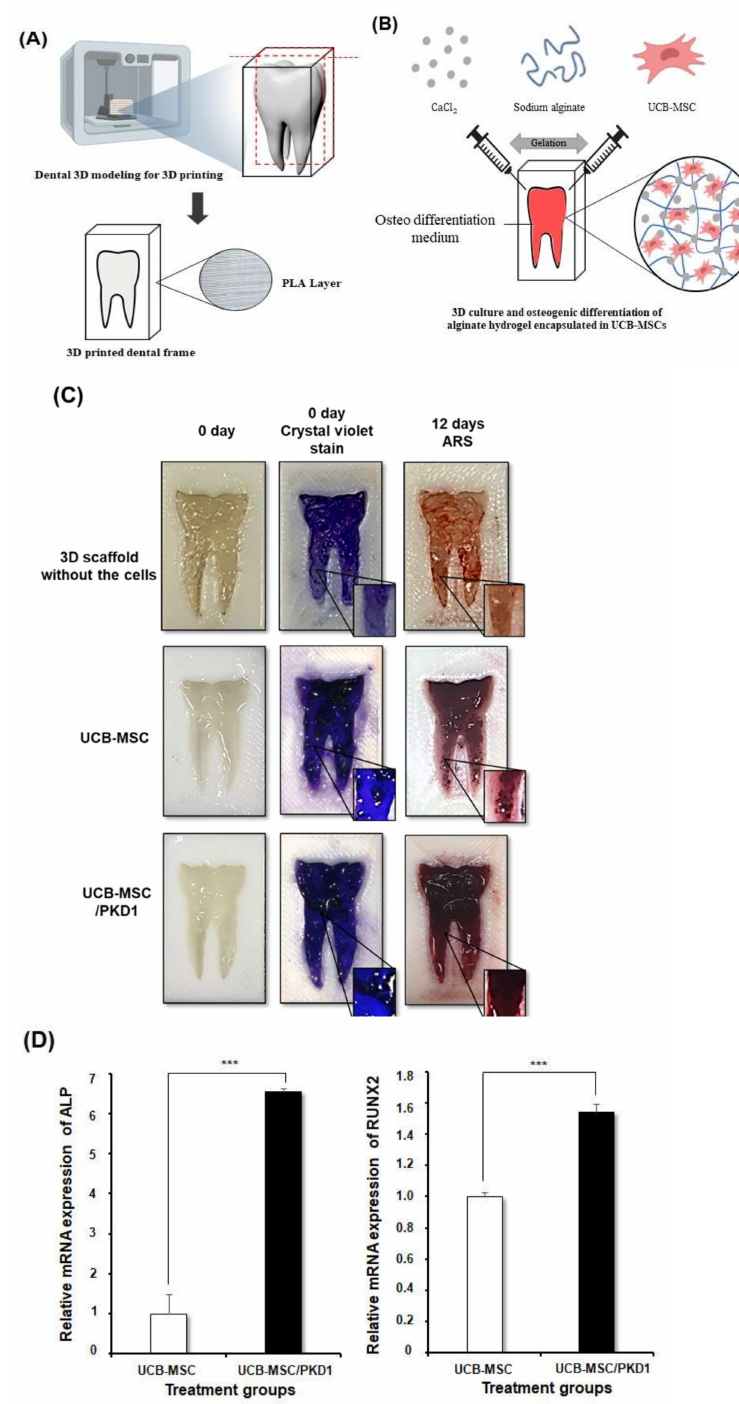
Figure 6. Improved osteogenic differentiation ability of UCB-MSC expressing PKD1 in a tooth mimetic 3D model by 3D cell culture and 3D printing. ( A ) The fabrication of artificial tooth model by 3D printer technique. ( B ) Tooth mimetic 3D model scheme with alginate hydrogel encapsulated with UCB-MSC/ PKD1 in a 3D tooth template for inducing osteogenic differentiation. ( C ) The images of cell viability and the differentiation levels by crystal violet and alizarin red S staining. ( D ) The mRNA expression levels of osteogenic differentiation markers of UCB-MSC expressing PKD1 in artificial tooth mimetic 3D model. Data shown represent the mean ± SD ( n = 3). *** p < 0.01 for the UCB-MSC only group versus the UCB-MSC/ PKD1